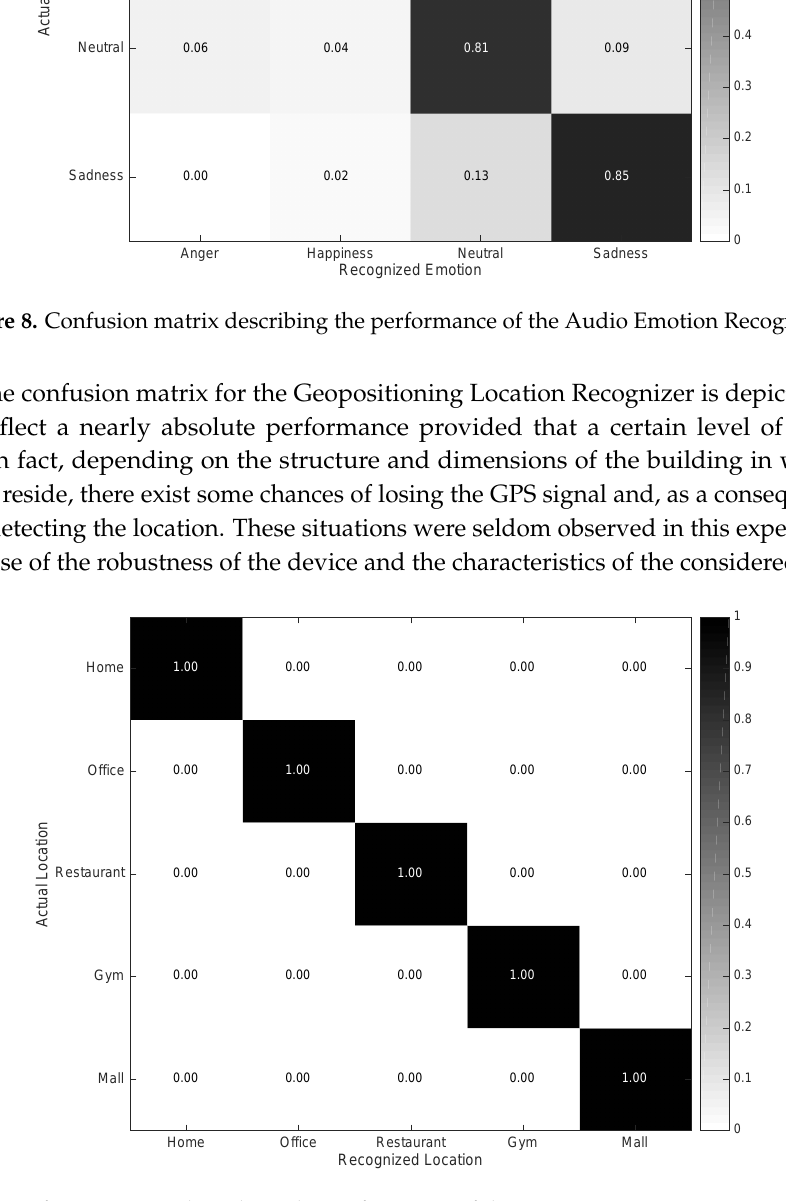
Figure 9. Confusion matrix describing the performance of the Geopositioning Location